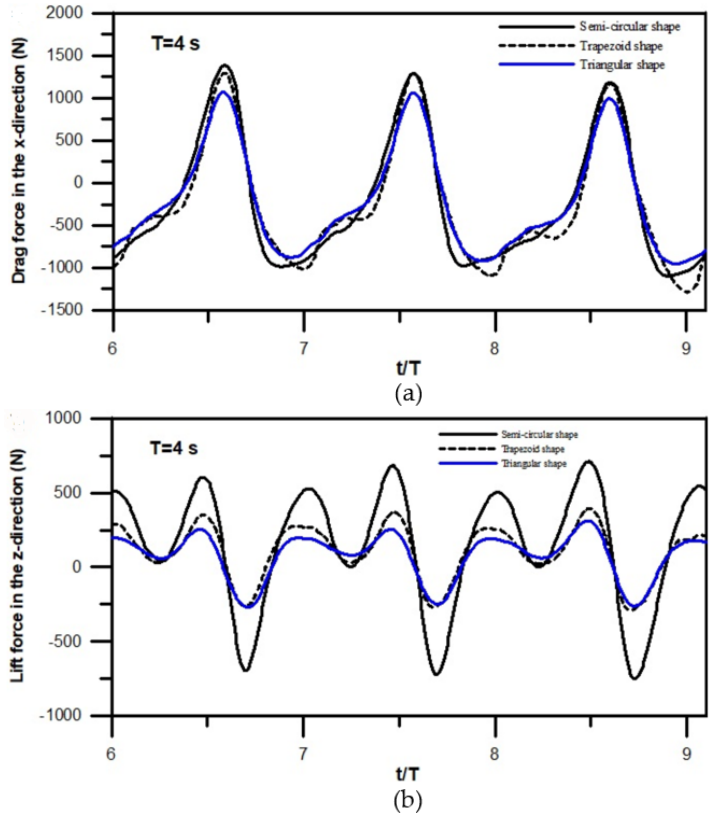
Figure 17. Simulation of the ( a ) drag and ( b ) lift forces for the different configurations of the submerged structures with the incident wave height H i = 0.2 m and T = 4 s.